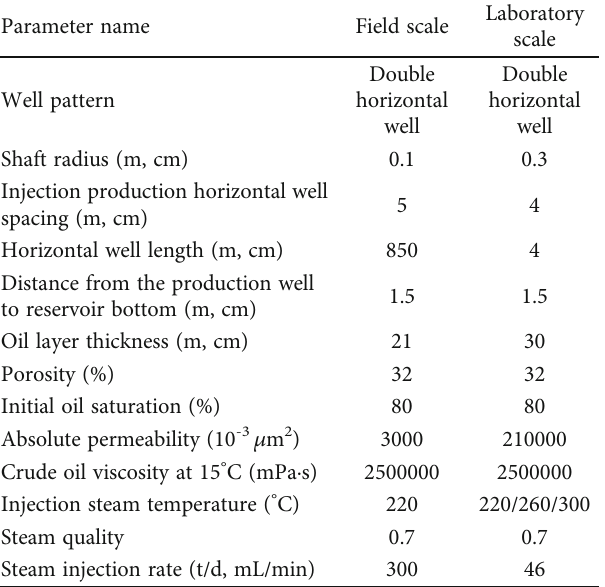
Table 1: Similarity parameters of the fi eld and experiment.